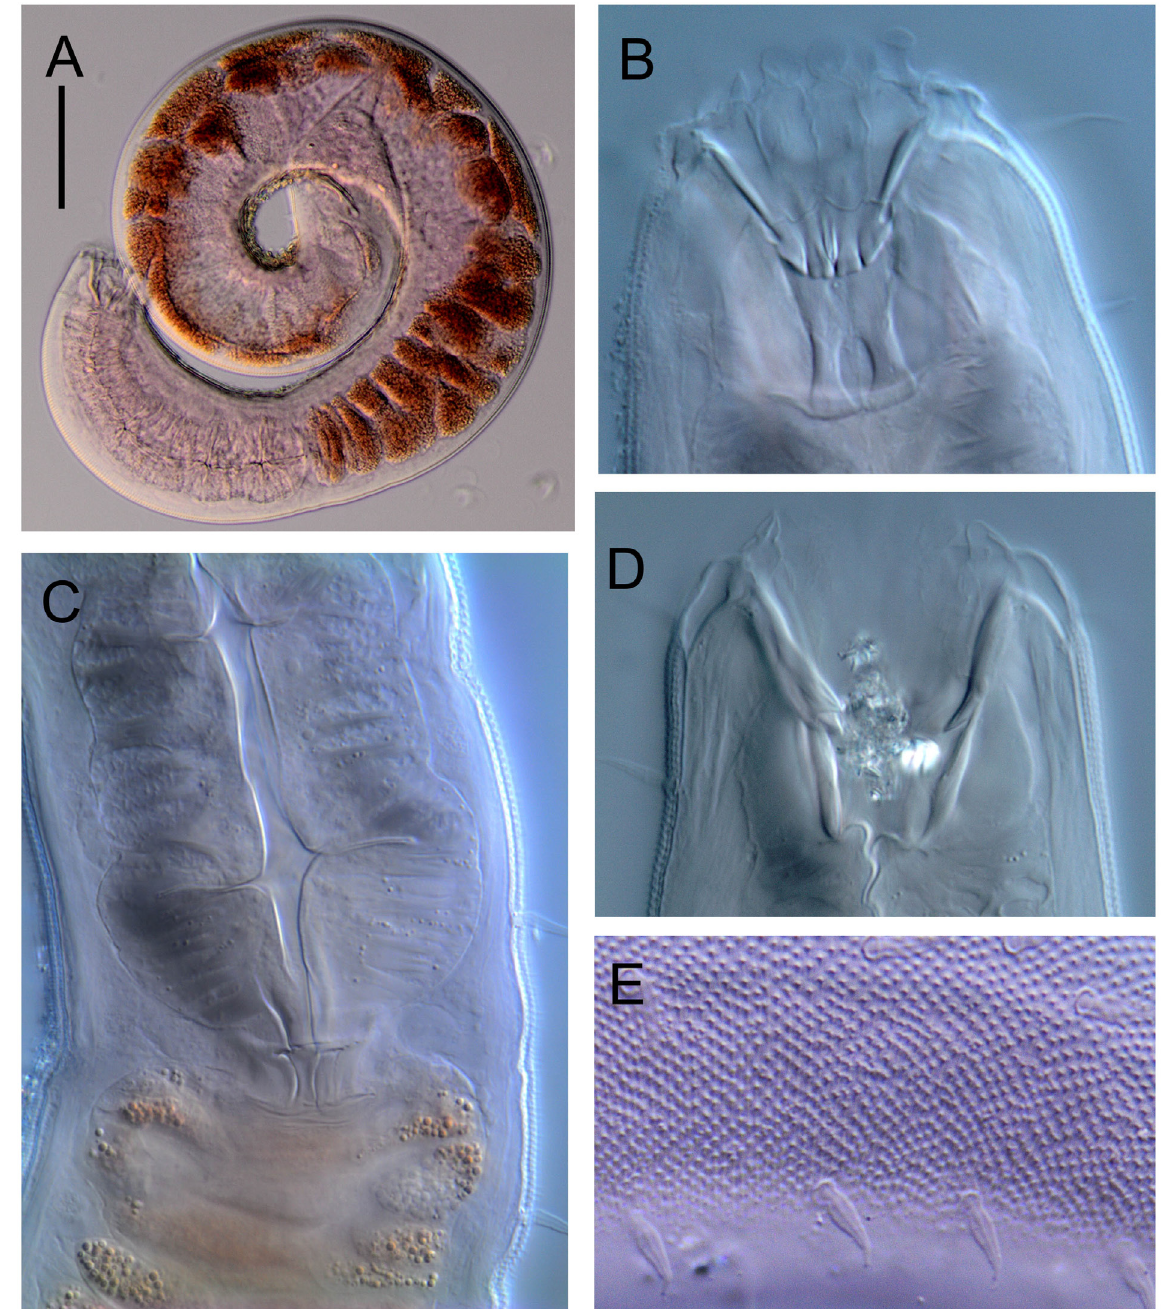
Fig. 13. Gammanema agglutinans sp. nov. Light micrographs. A . Entire male. B . Buccal cavity of female, showing paired rhabdions in posterior buccal cavity. C . Posterior region of pharynx, cardia, and anterior region of intestine of female. D . Buccal cavity of female, showing pointed projections at posterior extremity of rhabdions in anterior buccal cavity. E . Cuticle of male, showing punctations, spines, and somatic setae. Scale bar A = 30 µ m; B, D = 15 µ m; C = 12 µ m; E = 7